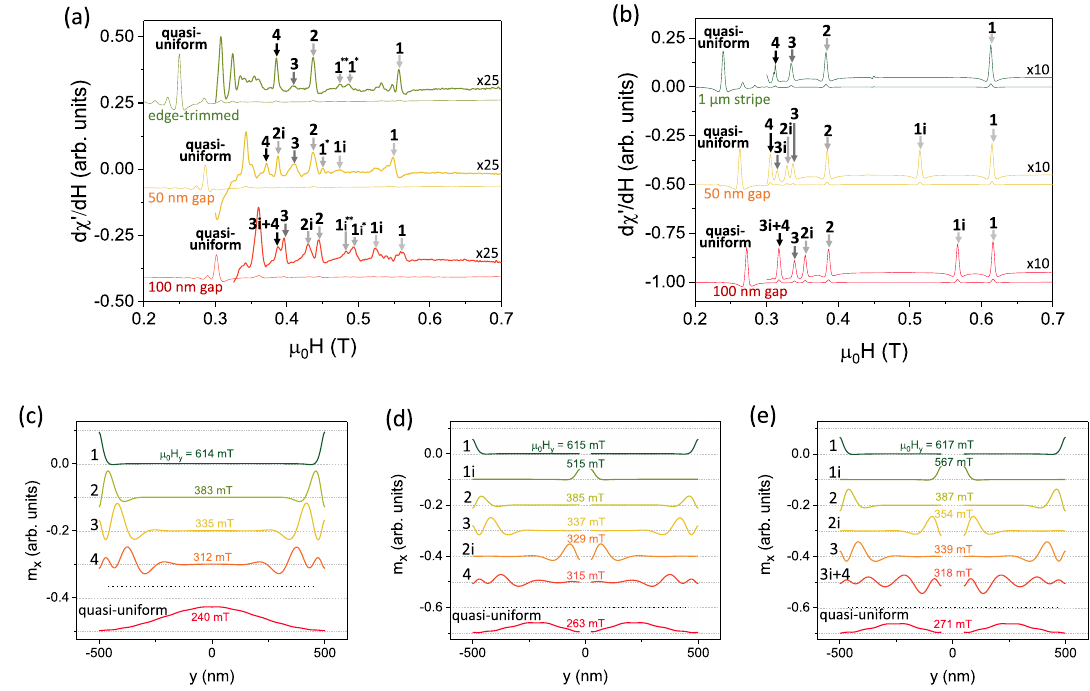
◦ Figure 3. ( a ) Field-swept µ FMR spectra measured for φ H = 180 on the edge-trimmed strip (top green curve), and cut with 50 nm (middle yellow curve) and 100 nm gaps (bottom red curve), respectively. ( b ) Corresponding simulated FMR spectra of an infinitely long strip with 1 µ m × 50 nm cross section, two strips with 475 nm × 50 nm cross section separated by 50 nm, and two strips with 450 nm × 50 nm cross section separated by 100 nm gap, respectively. The spectra in ( a ) and ( b ) show the field-derivative of the dispersion signal d χ ′ / dH and are vertically offset for visual clarity. Numbers in ( a ) and ( b ) denote the mode order (see text). ( c – e ) x-components of the mode profiles of the single strip ( c ) and HIM-cut strips ( d , e ) for the bias field values corresponding to the resonances observed in b ). The linescans are vertically offset for better